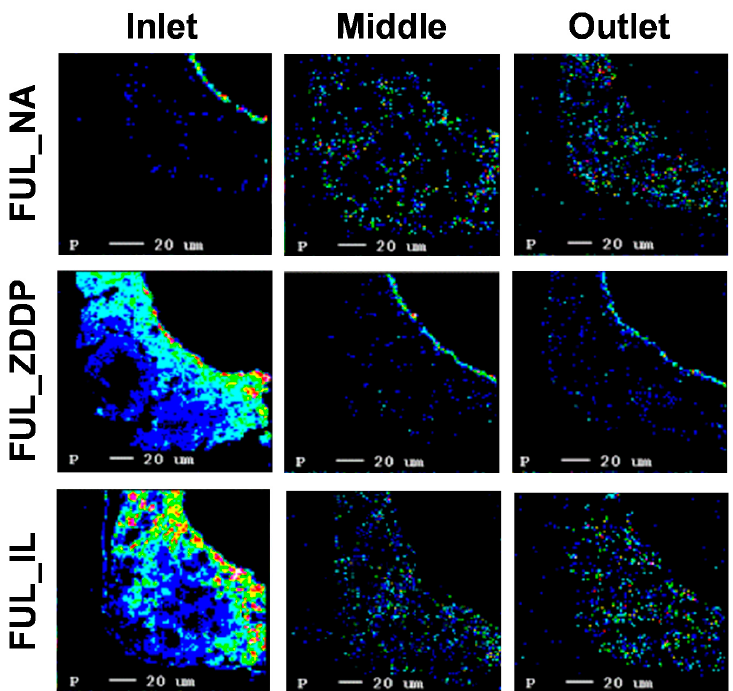
Figure 4. EPMA elemental maps of P for the inlet, middle, and outlet sections of FUL_NA, FUL_ZDDP, and FUL_IL.